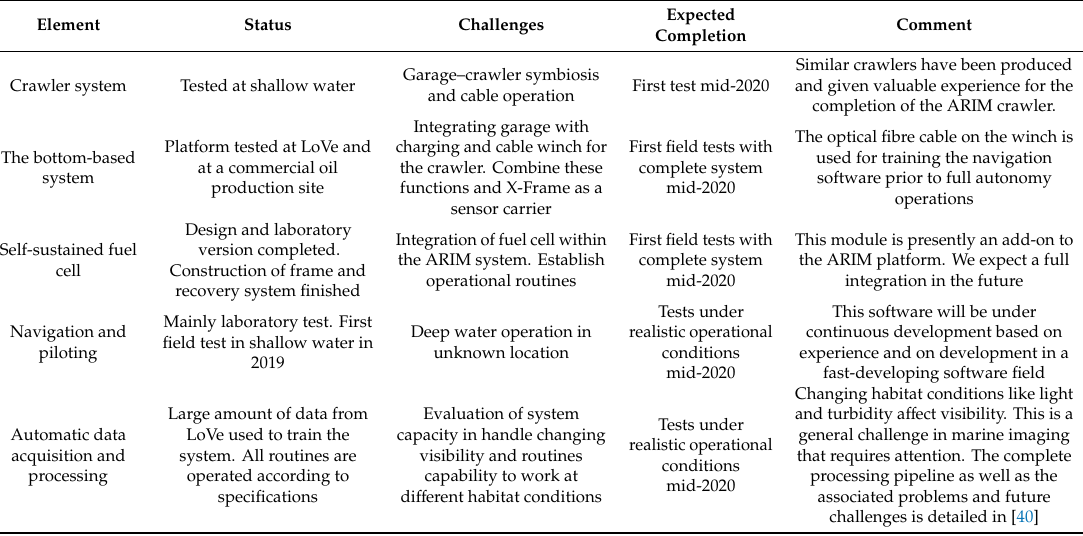
Table 2. Status, expected challenges during completion, and expected time of first full-scale testing.